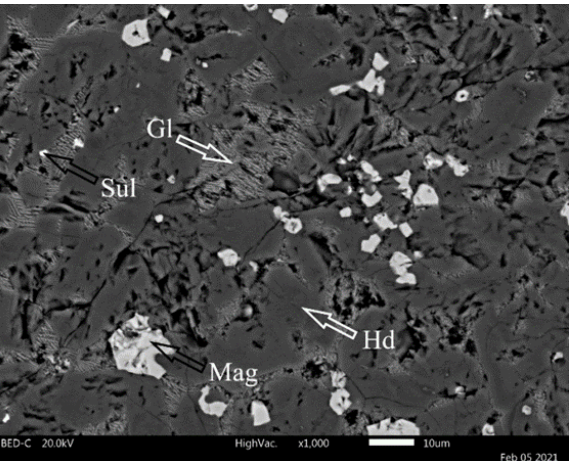
Figure 4. Backscattered electron image of sample CSA (abbreviations: Hd—hedenbergite; Mag—magnetite; Sul—sulphide droplets; Gl—galena).